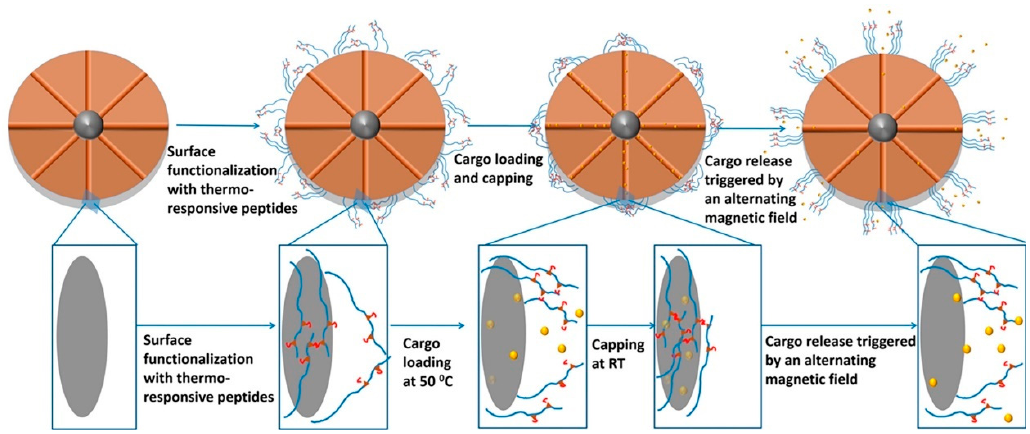
Figure 7. Schematic diagram of the working principle of heat-responsive peptide-modified nanovalve. The heat caused the decomposition of the peptide, leading to the release of the cargo from the pores of the MSN. Reproduced with permission from the publishers of corresponding reference [146].